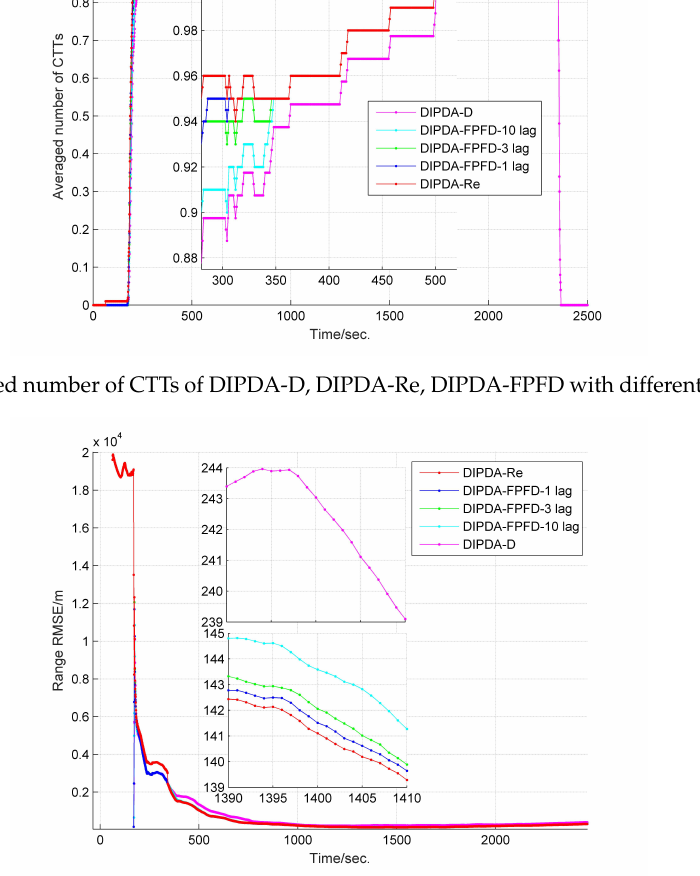
Figure 8. RMSE of estimated target range of DIPDA-D, DIPDA-Re, DIPDA-FPFD with different lags (case 1).